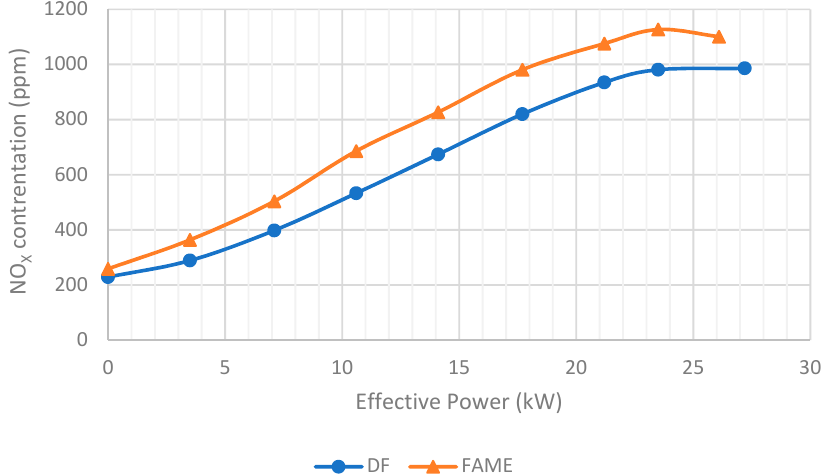
Figure 8. NO x emission level in the exhaust gas as a function of the effective power of the S-4003 engine, at an engine speed of 1600 rpm.